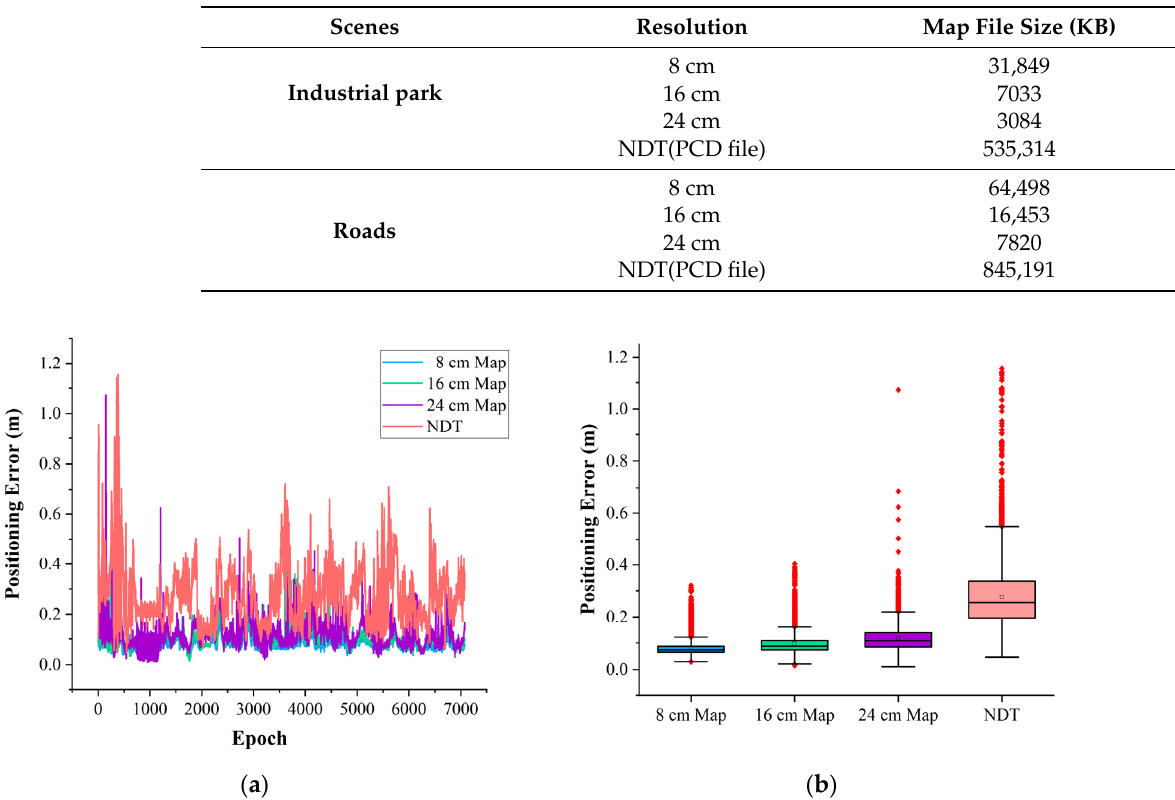
Figure 8. Time series and boxplots of positioning errors in industrial parks. ( a ) is time series of positioning errors and ( b ) is boxplots of positioning errors. Table 3. The RMS of position error using different resolution maps in different